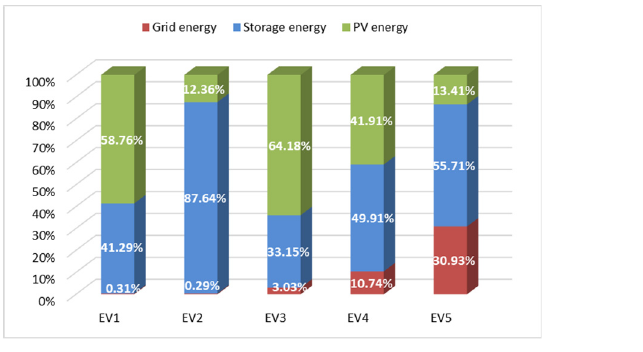
Figure 23. PV MPPT real and predicted powers and IIREV demand power—experimental test 2. Figure 24 shows the power flow and storage state of charge for “real-time exp” with- out optimization and the DC bus voltage—experimental test 2.